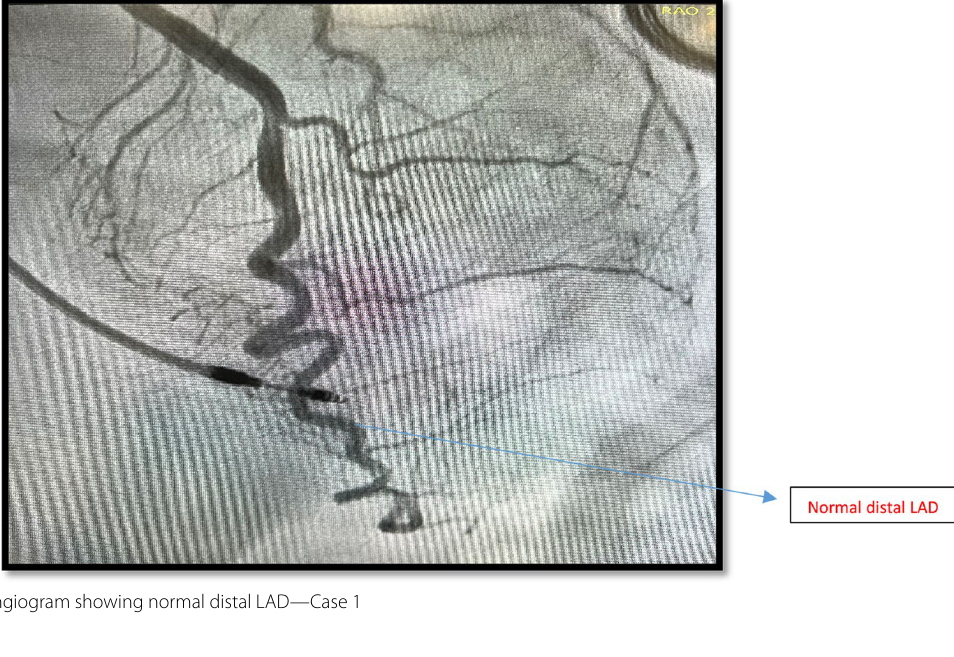
Fig. 4 Old angiogram showing normal distal LAD—Case 1